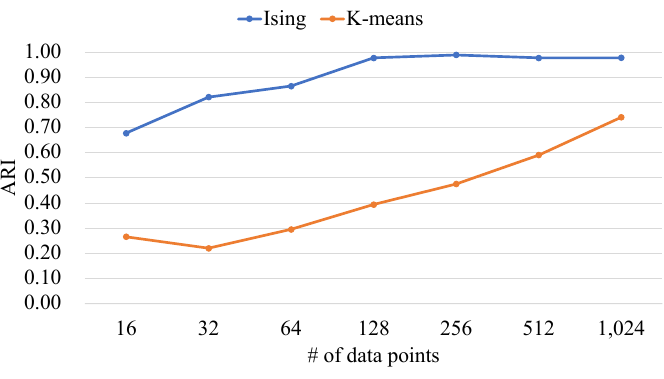
Figure 13. The ARIs of the proposed Ising-based kernel clustering and kernel